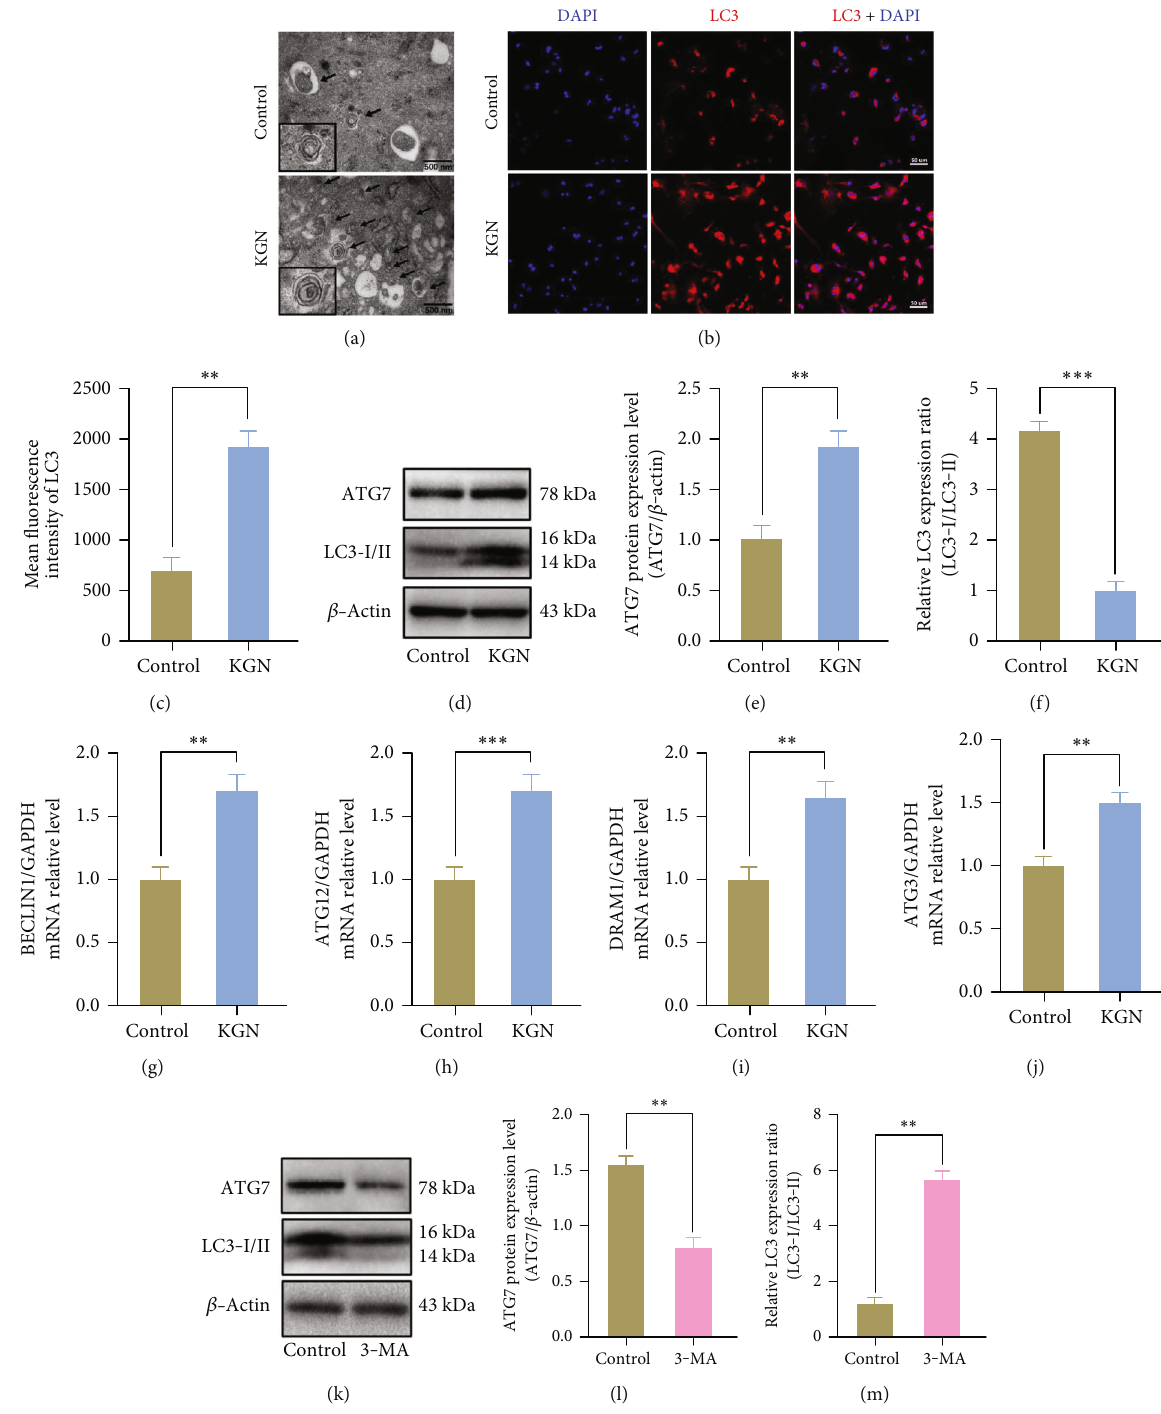
Figure 2: Autophagy is involved in the process of KGN-induced BMMSC osteogenesis. (a) The ultrastructural features of autophagic vacuoles by TEM. Black arrows suggest autophagosomes or autophagolysosomes in BMMSCs. Scale bar = 500 nm. Detection of LC3 (red) and DAPI (blue) by immuno fl uorescent staining (b) in the control and KGN-treated BMMSCs and semiquanti fi cation analysis (c). KGN upregulated the expression of autophagic marker LC3. Scale bar = 50 μ m. ∗∗ p < 0 : 01 , independent Student ’ s t test. (d) The e ff ects of KGN on autophagy-associated markers were evaluated by western blotting, (e, f) semiquanti fi cation of (d), and qRT-PCR of autophagy markers (g – j). KGN promoted the expression of ATG7 and downregulated the LC3-I/LC3-II ratio. ∗∗ p < 0 : 01 and ∗∗∗ p < 0 : 001 , independent Student ’ s t test. (k) The e ff ects of inhibitor 3-MA on autophagy-associated markers were evaluated by western blotting. (l, m) Semiquanti fi cation of (k). 3-MA inhibited the expression of ATG7 and upregulated the LC3-I/LC3-II ratio. ∗∗ p < 0 : 01 , independent Student ’ s t